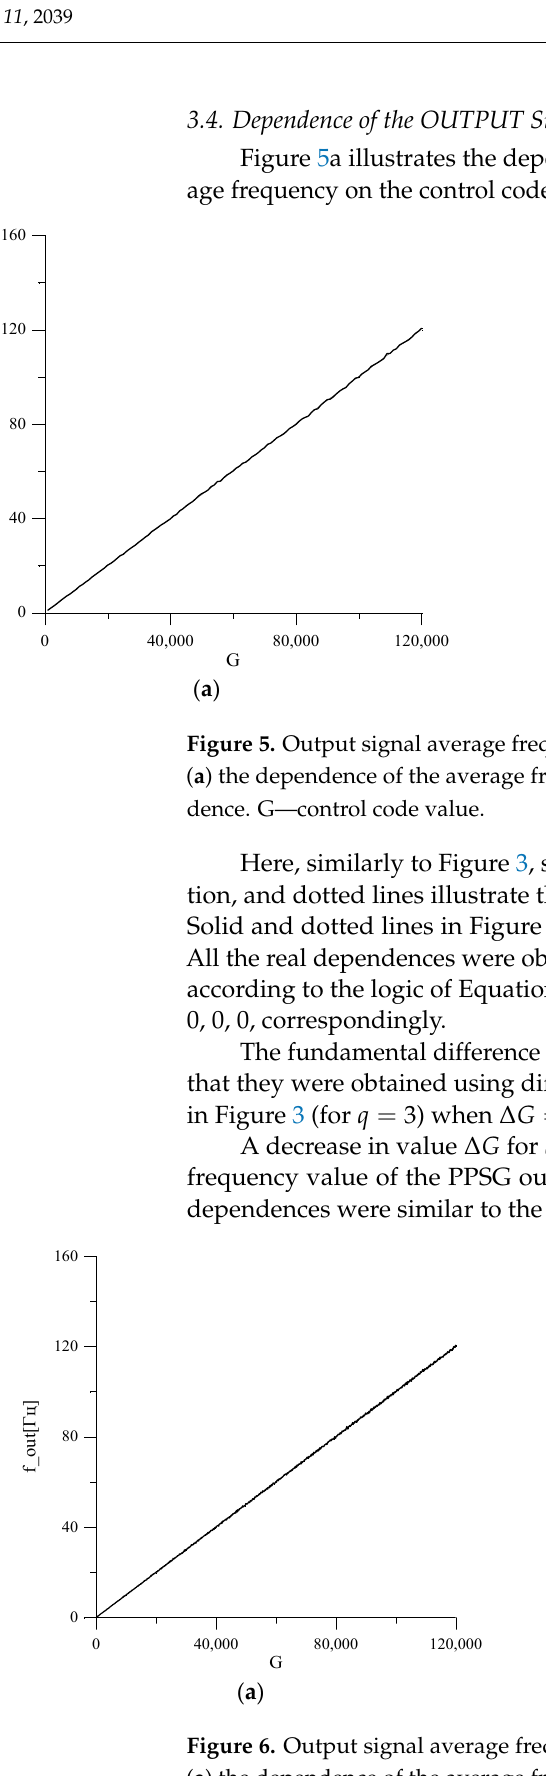
Figure 6. Output signal average frequency of the PPSG based on MAFG ( q = 6 ) , when ∆ G = 100: ( a ) the dependence of the average frequency on the control code G; ( b ) the fragment of that dependence. G—control code value.